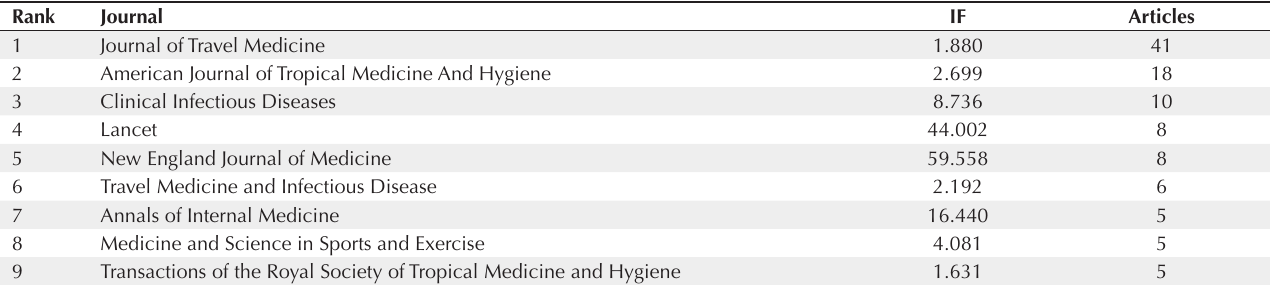
Table 2. Impact Factor (IF) of Journals Publishing the Most Cited Travel Medicine Papers